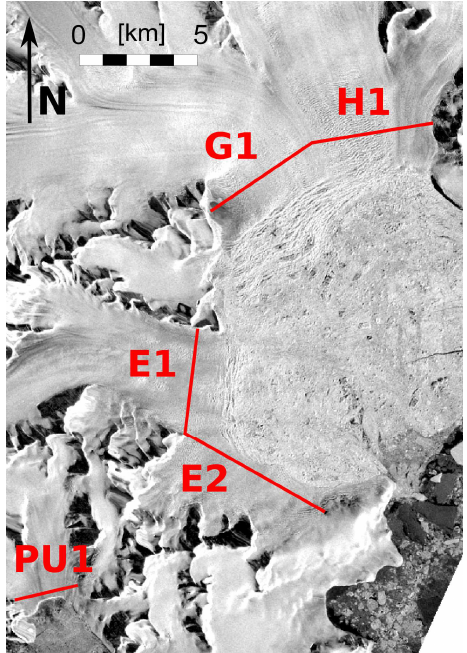
Figure 3. TerraSAR-X image of Antarctic Peninsula glaciers draining into the northern Larsen-B embayment, acquired on 18 October 2008 , with gates for mass fluxes as specified in Table 2.